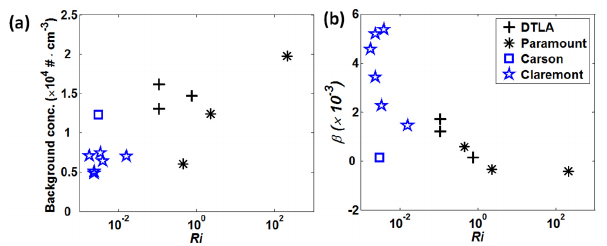
Figure 8. Dependence of (a) background UFP concentrations and (b) dispersion coefficient, β on atmospheric stability, represented by the Richardson number ( R i ) .